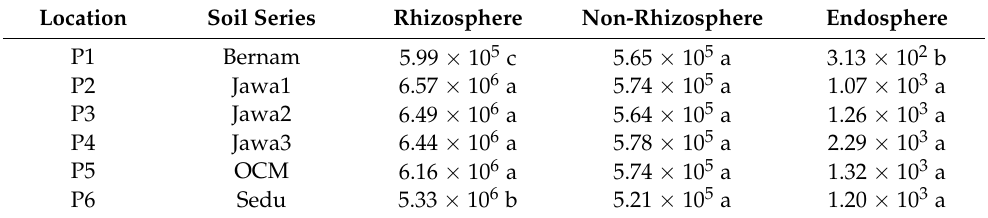
Table 4. Bacterial populations (CFU g − 1 ) in the non-rhizosphere, rhizosphere, and endosphere of wetland rice from different locations and soil series.